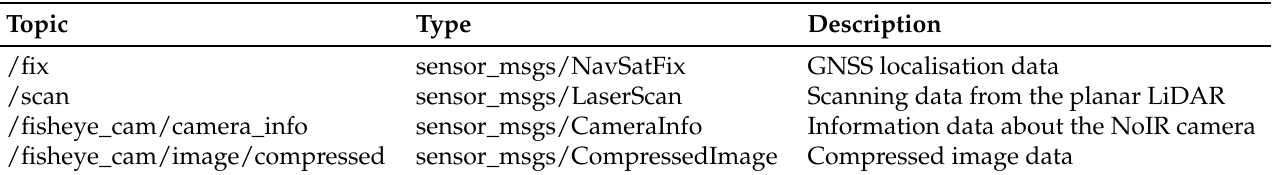
Table 1. Description of the dataset built with data acquired by the hardware